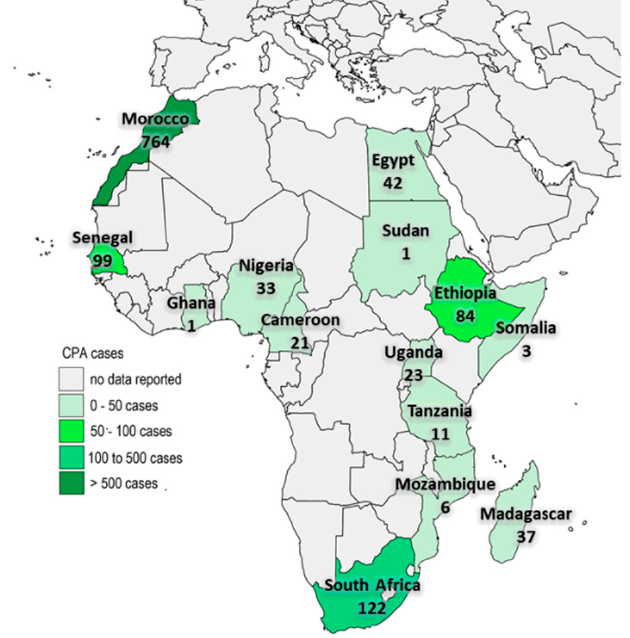
Figure 2. A map of Africa showing the distribution of CPA cases.